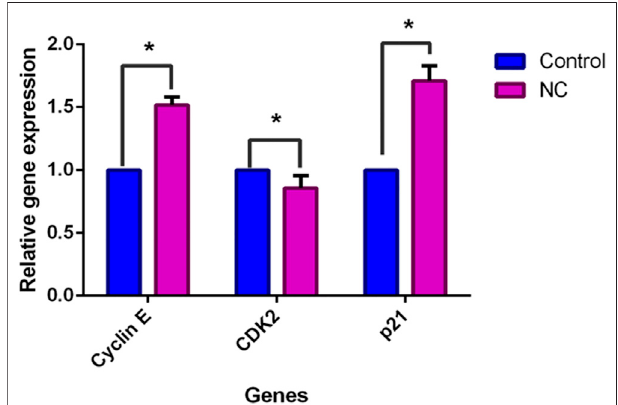
FIGURE4| EffectofNCleaves80%ethanolextractoncellcycle-related gene expression upon treatment with IC 50 for 72 h. Relative expression for cyclin E, CDK2, and p21 were calculated by measuring the fold change with GAPDH and β -actin as reference genes in untreated cells (the ratio was equal to 1). Data presented in mean ± standard deviation of triplicates of the experiment. * indicates a signi fi cant difference when p < 0.05.